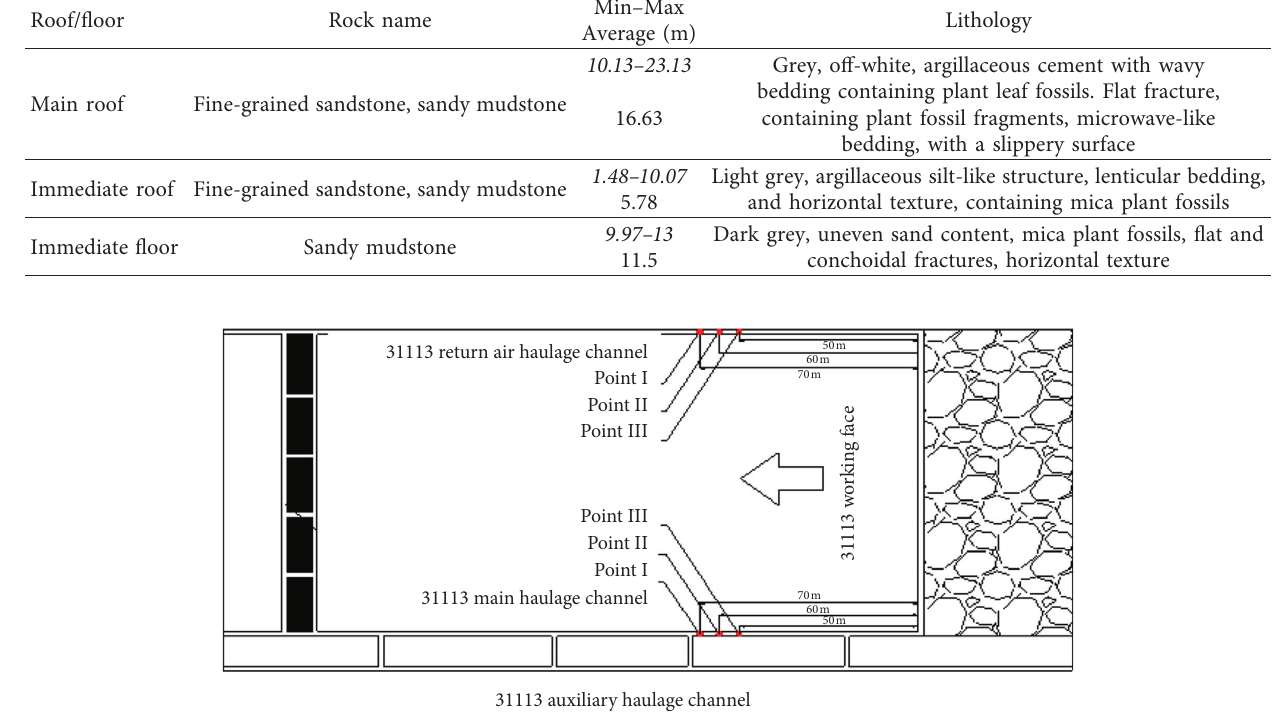
Figure 1: Layout of mine pressure monitoring points.